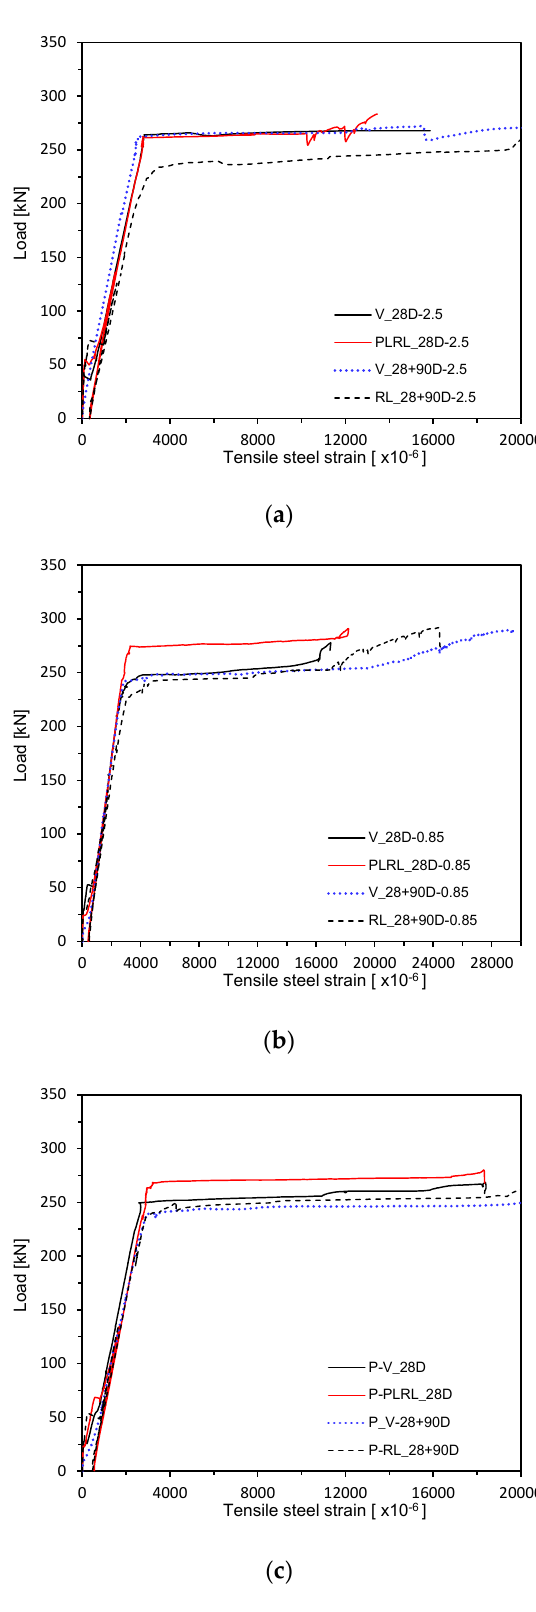
Figure 13. Load–steel reinforcement strain measurement by mixes: ( a ) 2.5 series; ( b ) 0.85 series; ( c ) Plain series.